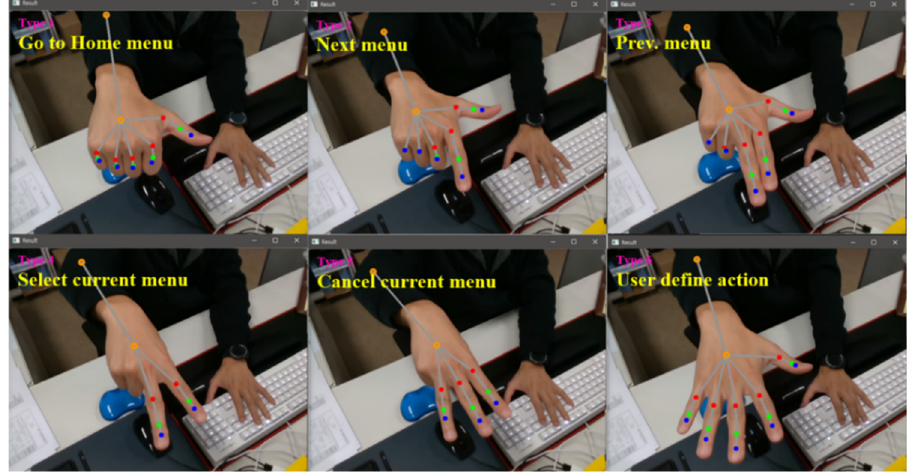
Figure 12. Gesture-type judgment results obtained through the gesture recognition algorithm.